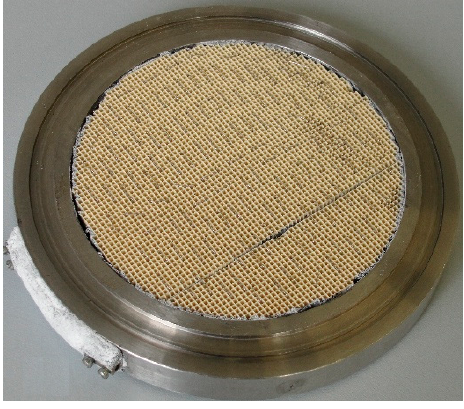
Figure 2. ( a )The stack placed inside the stack-holder; ( b ) a magnified view of a portion of the stack.